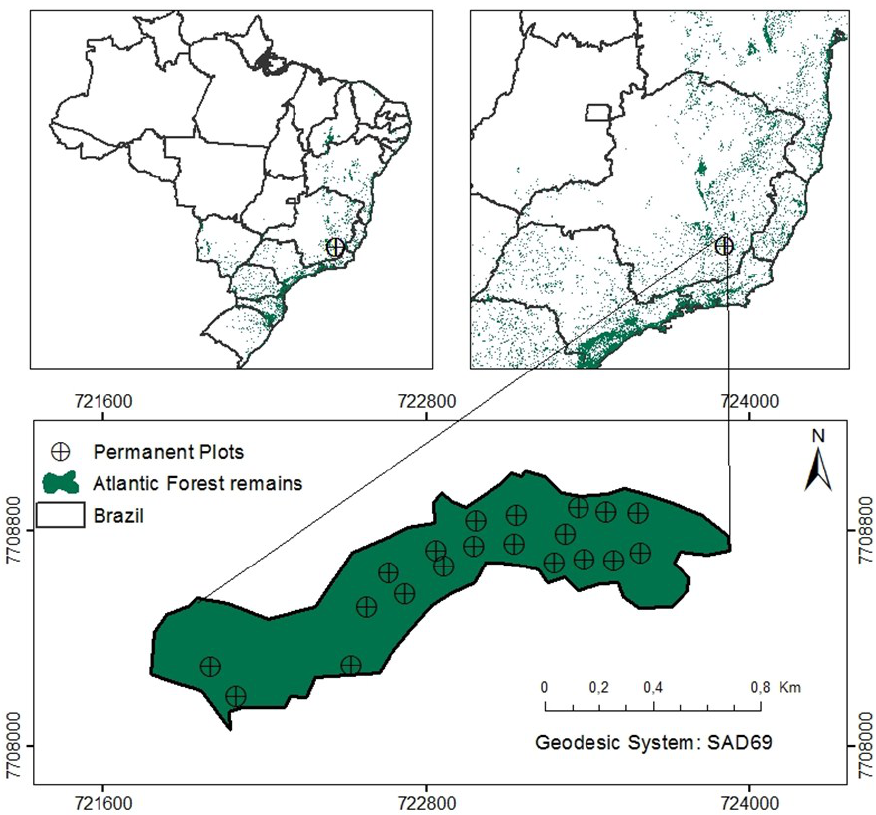
Figure 1. Location of the secondary Atlantic Forest fragment and distribution of permanent plots in the area.